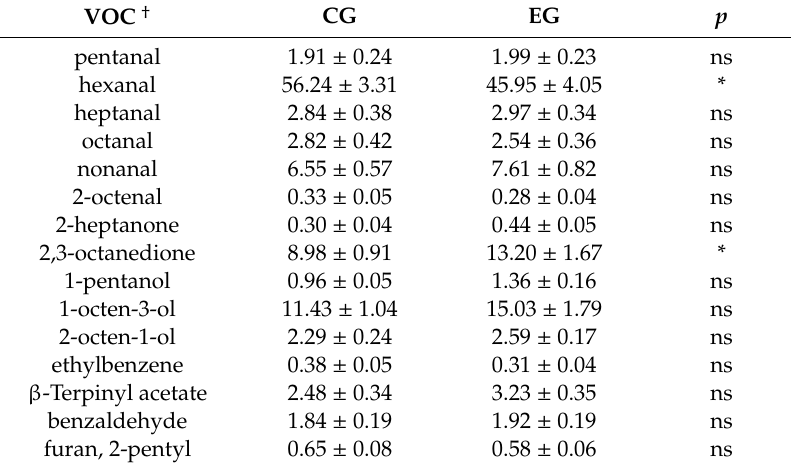
Table 5. Volatile compounds (VOCs) detected after 7 days post mortem in beef samples obtained from animals fed a standard diet (CG) and animals fed a dietary supplementation of 10% dried grape pomace (EG). VOC † CG EG p pentanal 1.91 ±